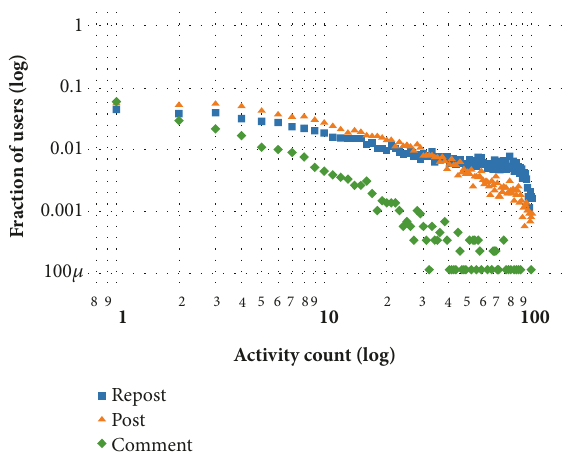
Figure 11: Distribution of posts, reposts, and comments on personal walls of subscribers of bank community.